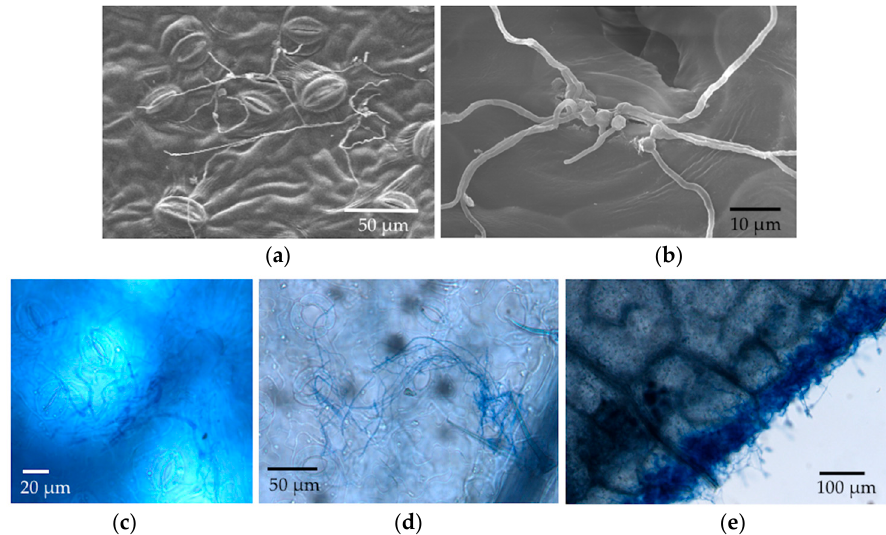
Figure 5. SEM photos from the in vitro inoculation of leaf discs of P. trichocarpa with an endophytic strain of Penicillium citrinum 0079. ( a ) Low magnification view of lower epidermis, six HAI; ( b ) Non- germinated conidia are dispersed on lower epidermis, 24 HAI; ( c ) Non-germinated conidia at high magnification, 24 HAI; ( d ) Germinated and non-germinated conidia at high magnification, 48 HAI; ( e ) Germinated conidia and hyphae, as well as non-germinated conidia, on lower epidermis, 48 HAI.